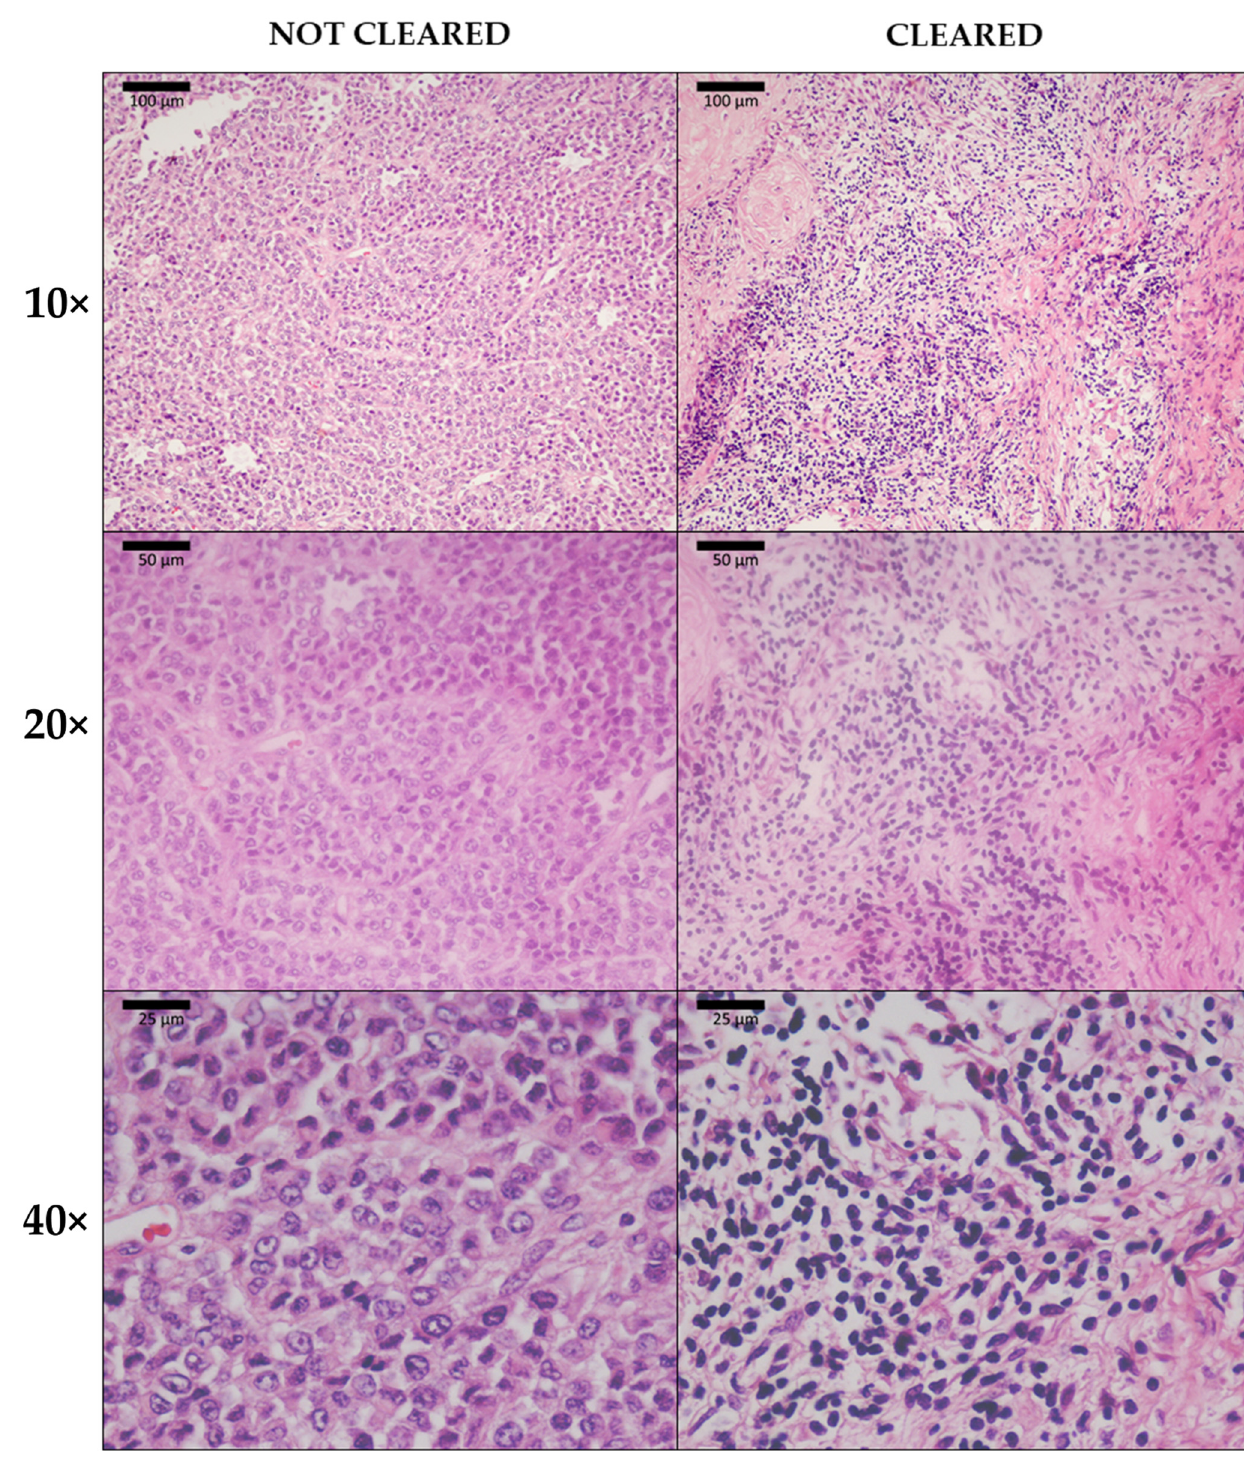
Figure 8. Hematoxylin and eosin (H&E) staining of uncleared tissue (left) and CUBIC-cleared tissue (right) in 10×, 20× and 40× magnification. The window/level was adjusted uniformly on all images for better visualization.